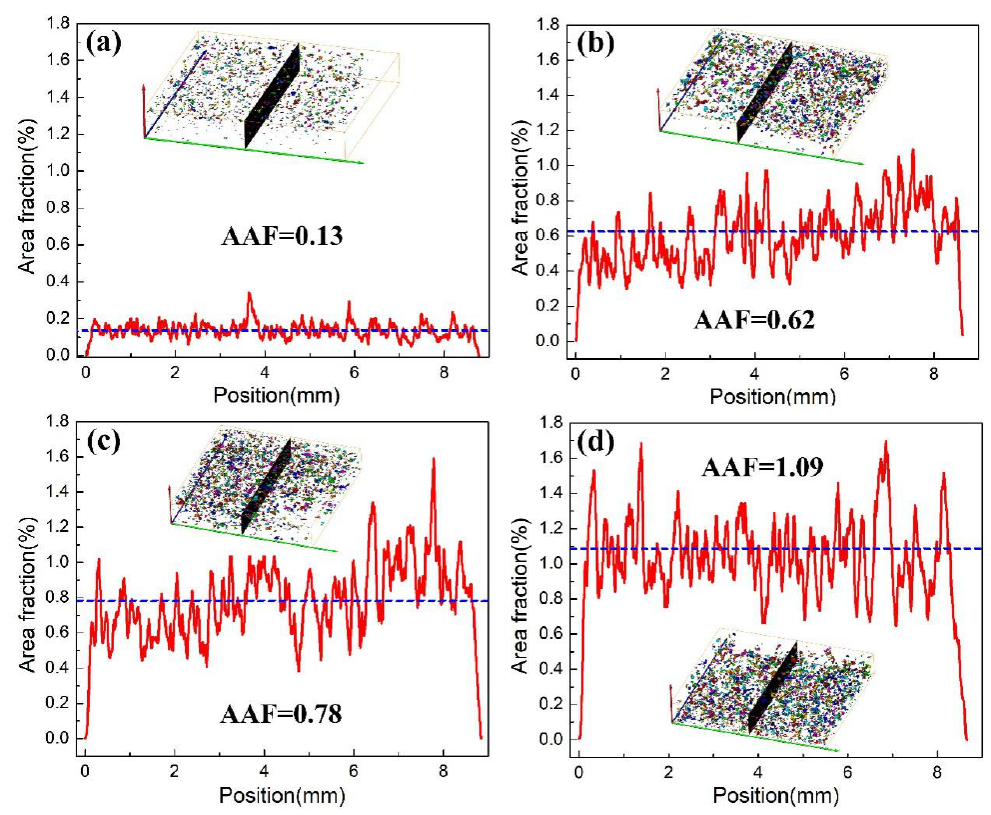
Figure 11. Hydrogen blister area fraction along longitudinal section: ( a ) 30 min; ( b ) 180 min; ( c ) 300 min and ( d ) 480 min. AAF: average area fraction.